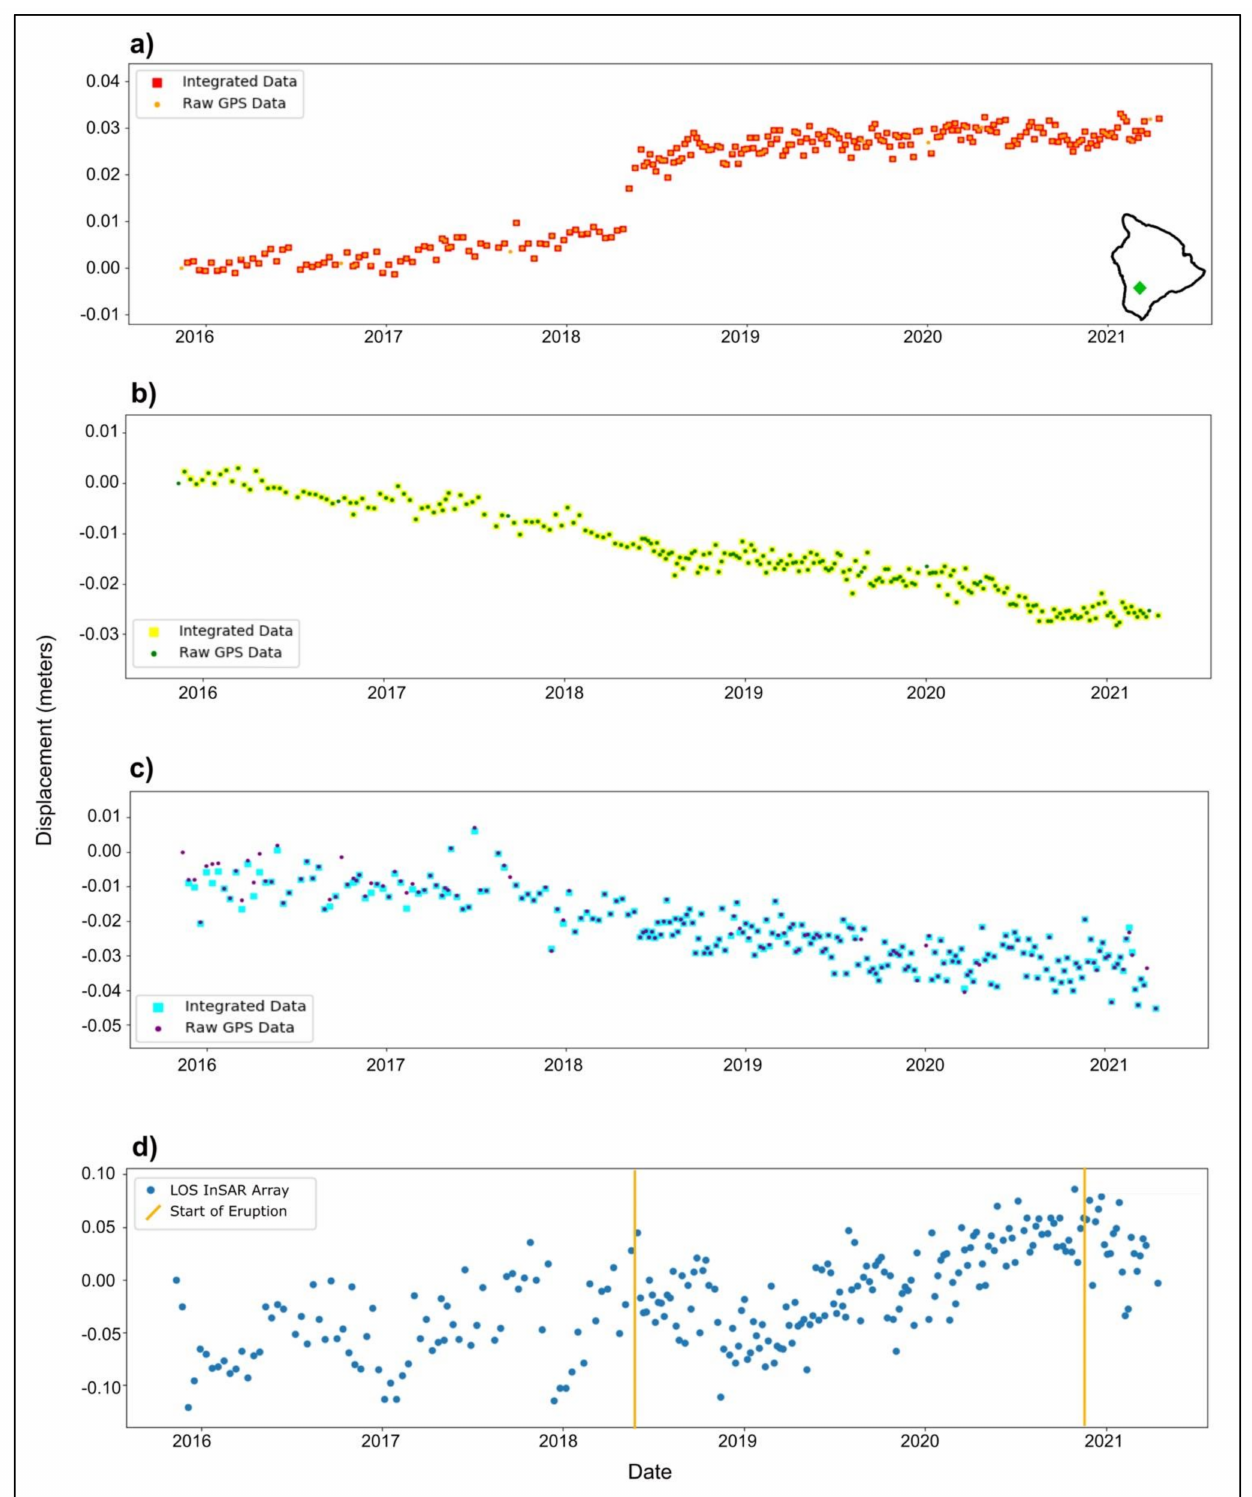
Figure 11. Integrated results compared to original, raw GNSS time series in the ( a ) east-, ( b ) north-, and ( c ) up-components of motion at BLBP GNSS station (19.355 ◦ N, –155.711 ◦ W). ( d ) DInSAR LOS time series at the same pixel, BLBP station. Yellow lines are as in Figure 8, above. The inset in subfigure a shows location of BLBP station in